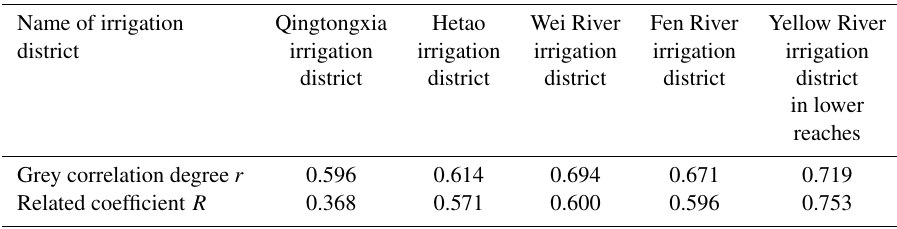
Table 5. Correlation relationship between irrigation requirement and RDI drought index of main irrigation districts of Yellow River. Name of